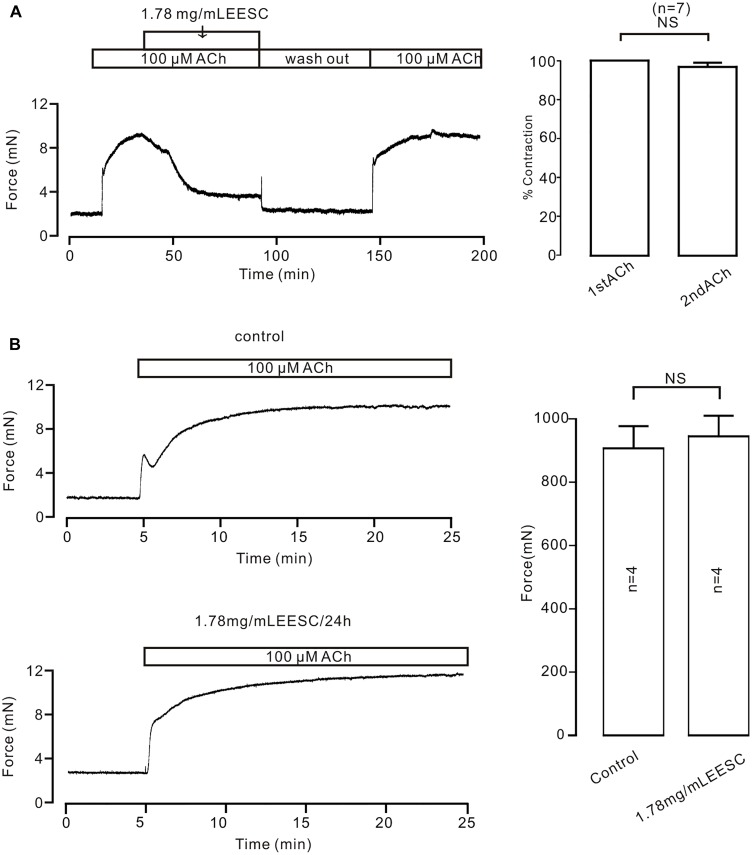
The effect of EESC is reversible. (A) ACh induced similar contractions in TRs after washout of EESC. (B) ACh-caused contractions were similar in TRs treated with EESC for 24 h and controls. NS: P > 0.05. These data suggest that EESC-induced relaxation is not due to EESC-induced cytotoxicity and inhibition of the contraction-related protein expression.